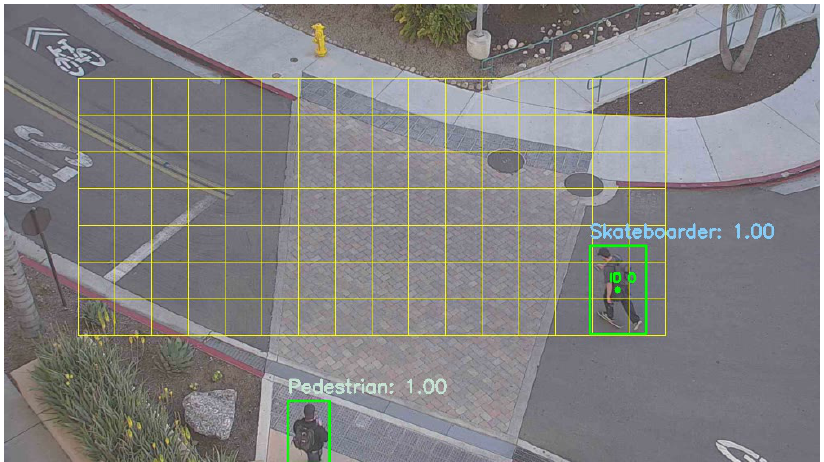
Figure 23. The grid area is reduced to solve the occlusion problem. In this figure, a skateboarder is misclassified as a pedestrian due to